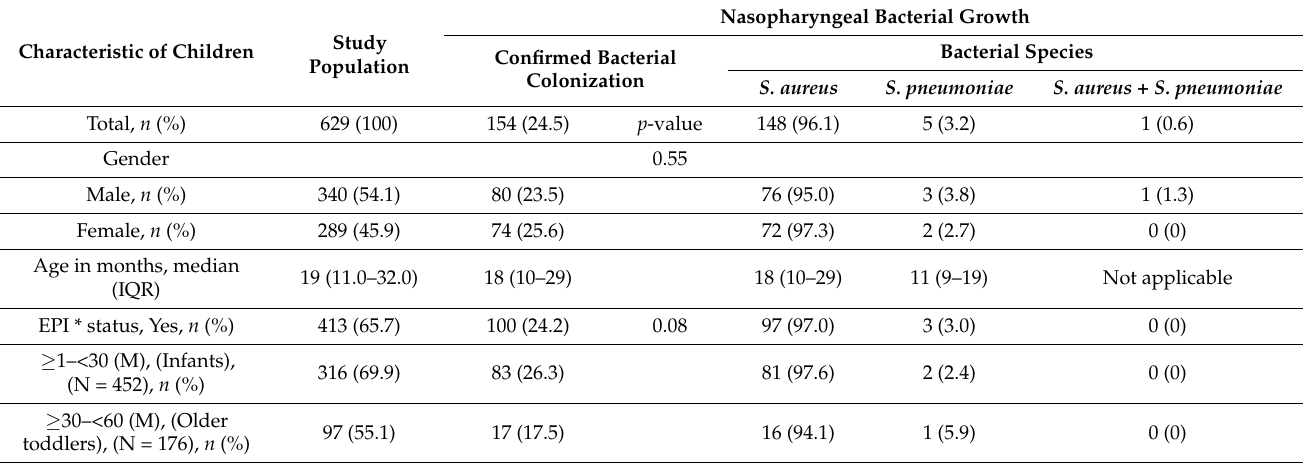
Table 1. Study population characteristics.